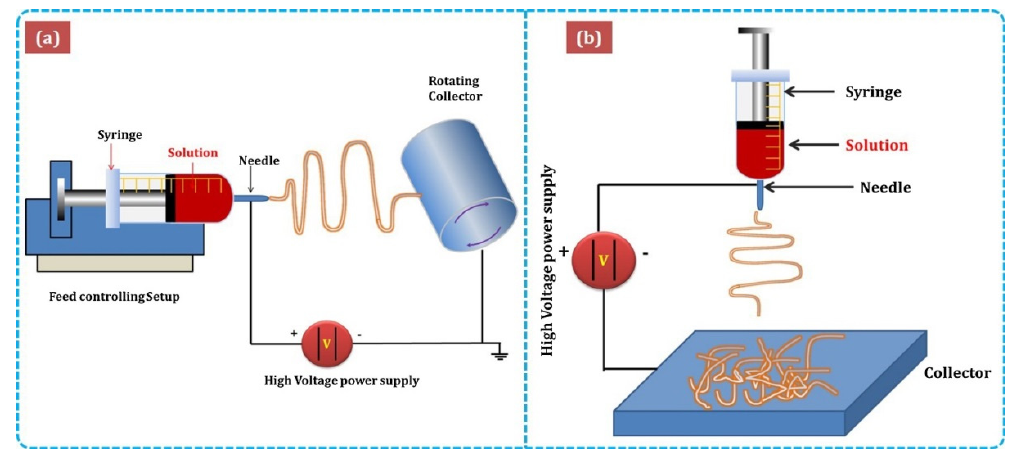
Figure 3. Schematic diagram of ( a )horizontal and( b )vertical setups of electrospinning [34].